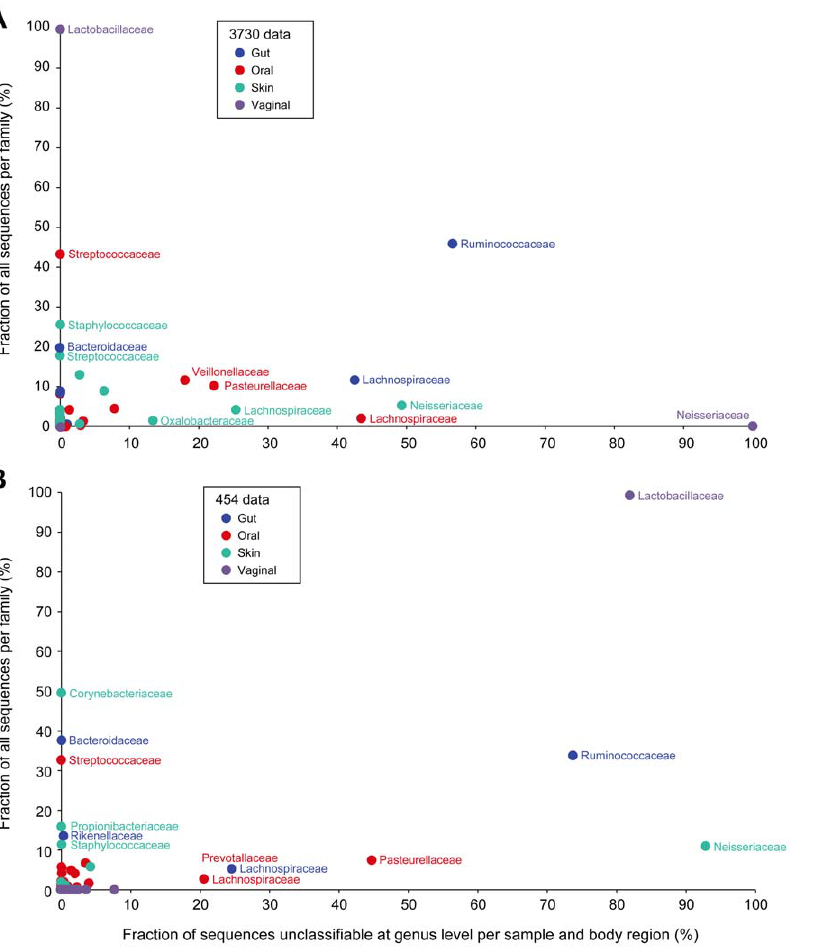
Figure 10. Classifiability of 16S sequence data is differentially impacted by sequencing technology, taxonomic family and body region. For each of the HMP body regions, the relationship between the average frequency of a given bacterial family (y-axis) versus the contribution of these families to the unclassifiability issue (x-axis) is plotted for (B) 3730 and (C) 454. Only window V3–V5 is presented in 454 results. Classification was performed on quality- and chimera-filtered sequences and classifications assigned only if the RDP Classifier result had a confidence score above 80%.